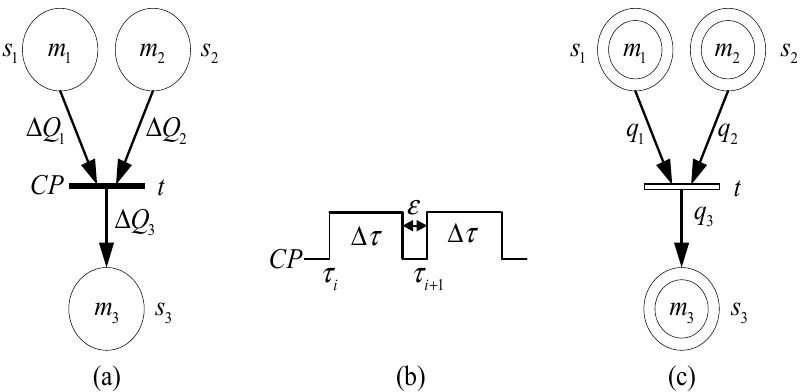
Figure 4. Continuous transition. ( a ) Discrete transition ( b ) timing sequence ( c ) Continuous